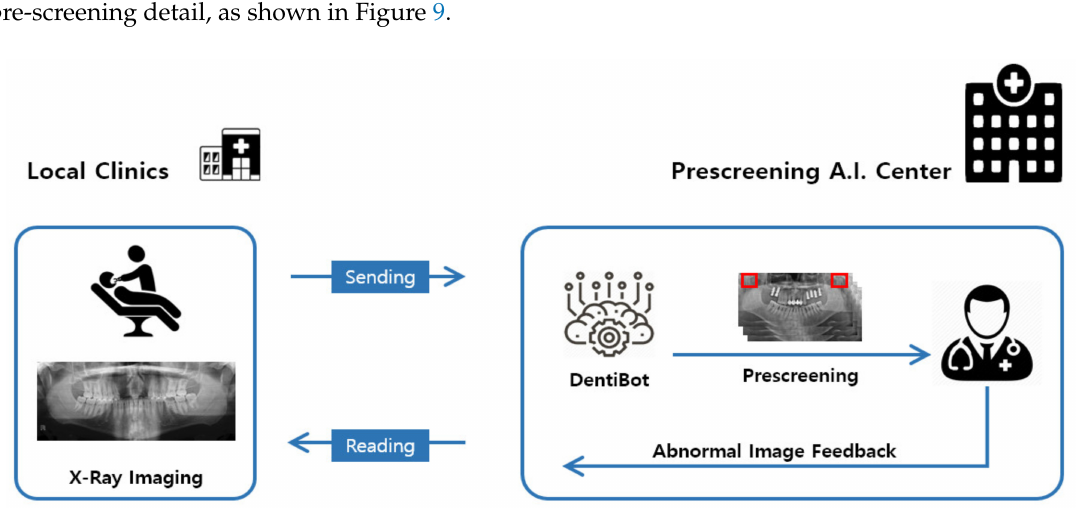
Figure 8. Remote reading support expert